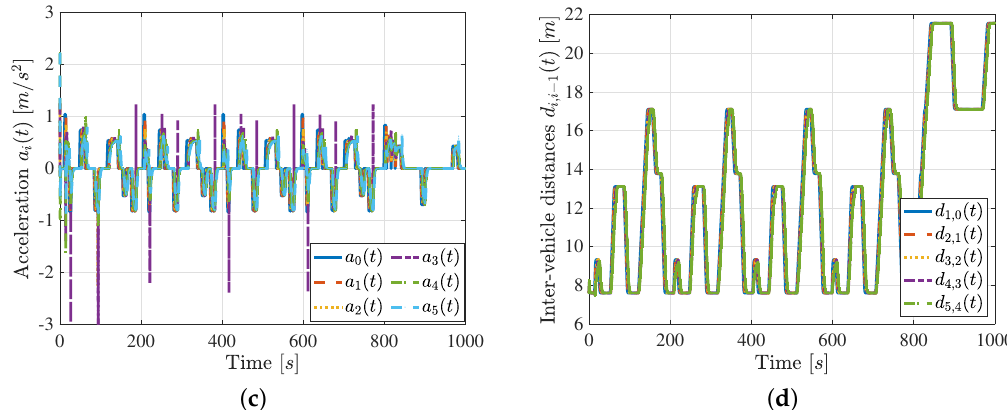
Figure 3. Basic scenario-tracking performances. Time history of: ( a ) energy-optimal leader speed profile; ( b ) vehicles speed v i ( t ) , i = 0, . . . ,5; ( c ) vehicles acceleration a i ( t ) , i = 0, . . . ,5; and ( d ) inter-vehicle distances ¯ d i , i − 1 ( t ) , i = 1, . . . ,5